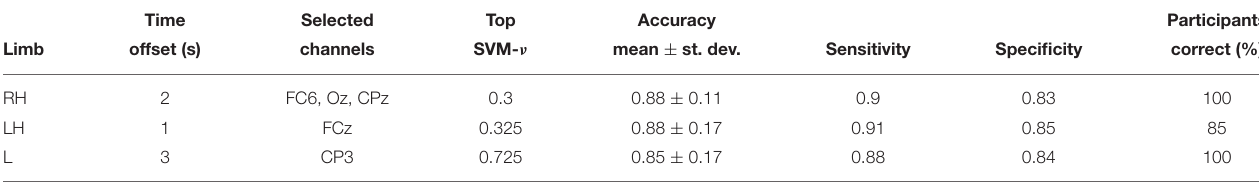
Frontiers in Neuroscience |